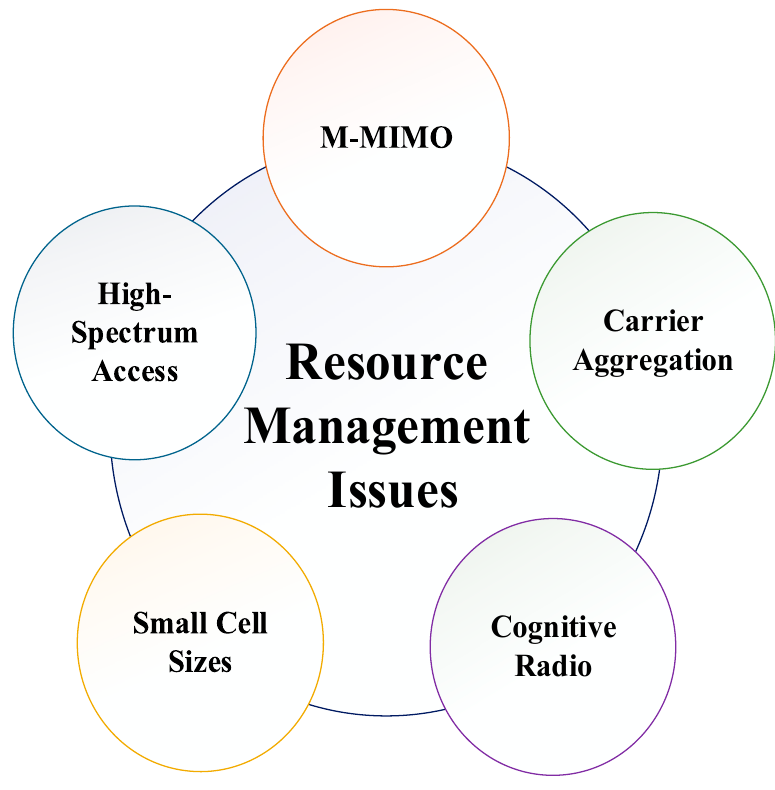
Figure 1. Spectrum management issues.